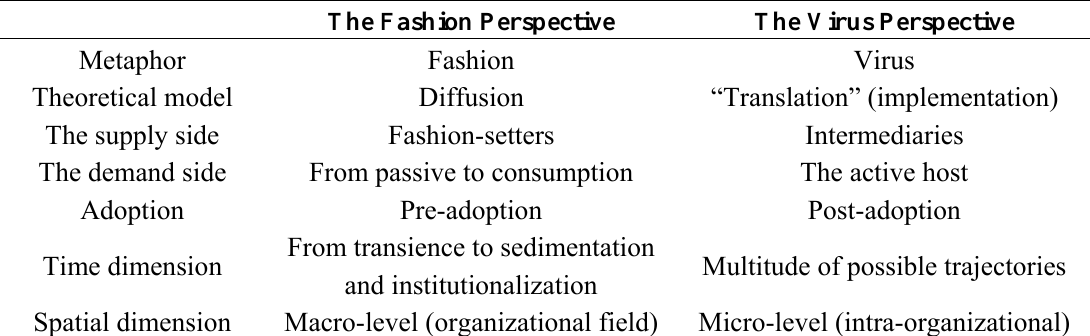
Table 2. Comparison of the fashion and the virus perspective (source: